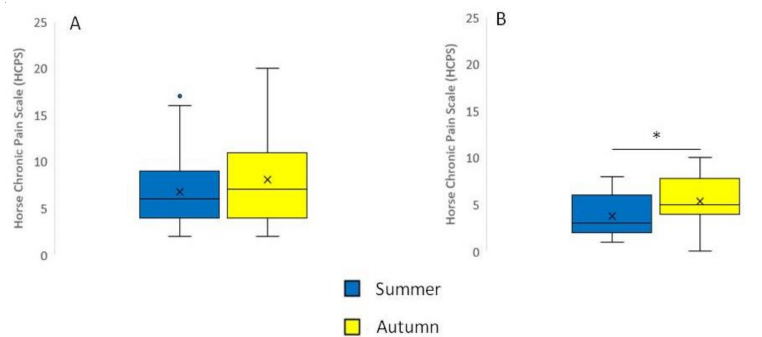
Figure 3. Patients and control animals during summer and autumn observations. ( A ) horses with chronic painful conditions during summer and autumn observations ( p = 0.20, n = 15). ( B ) healthy pain-free control horses during summer and autumn observations. Boxes show 25–75 percentiles, with the horizontal line being the median and the x being the mean score; whiskers show 5–95 per- centiles; open dots show outliers (* p < 0.05, n =